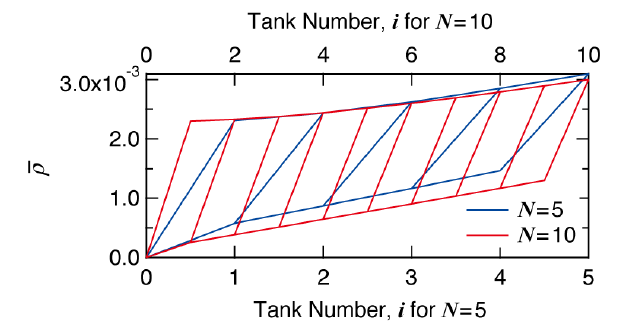
Figure 11. Development of average branching density r with the progress of tank number i for N = 5 (blue) and N = 10 (red).